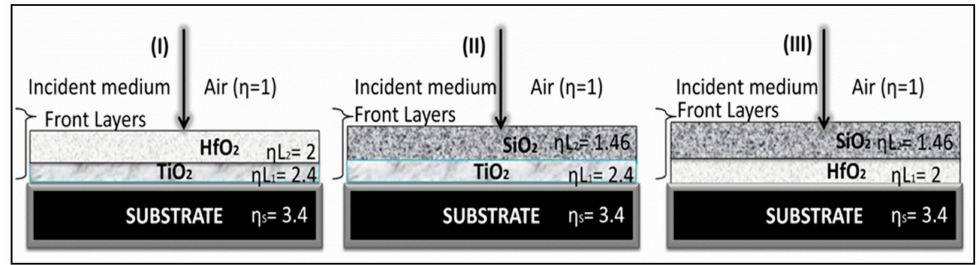
Figure 3. Schematic representations of a composite coating; a high-index and a low-index layer in a bilayer coating